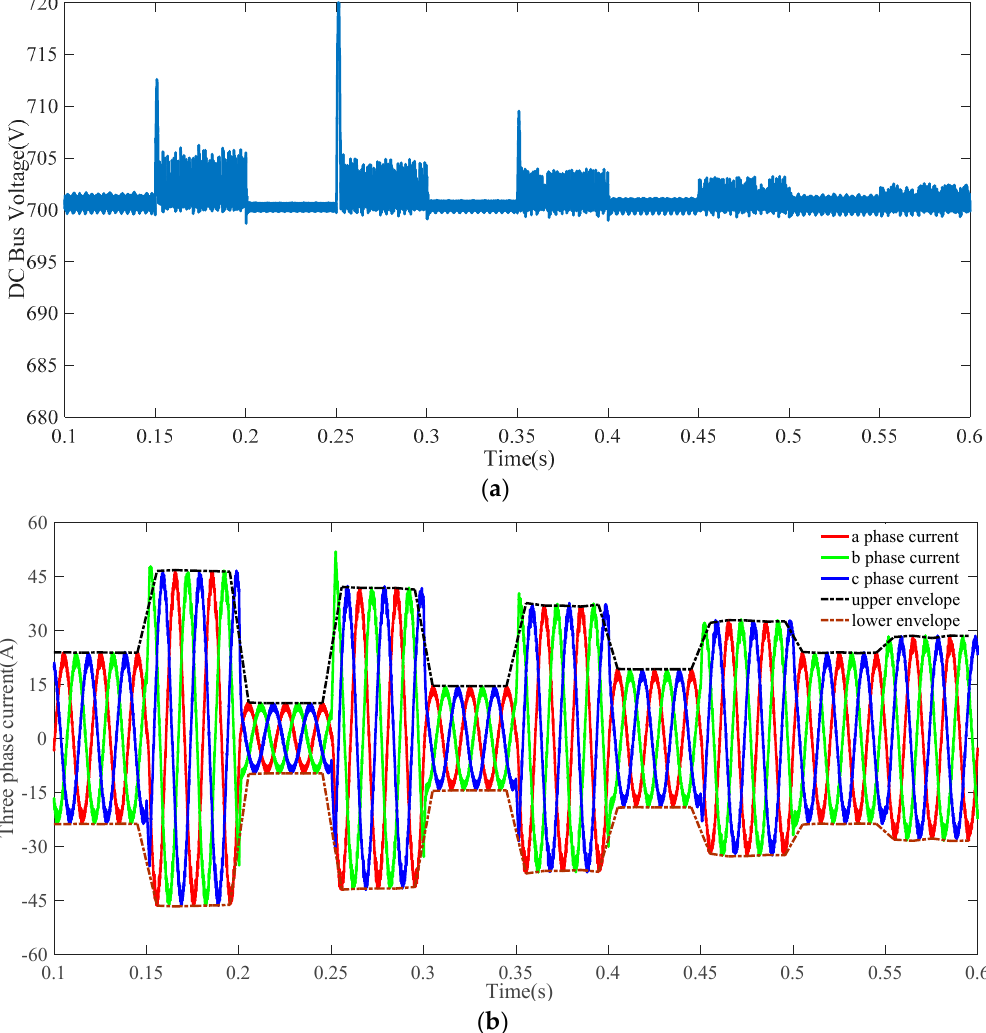
Figure 19. DC-link voltage and inverter output current: ( a ) DC-link voltage; ( b ) Three-phase output current.